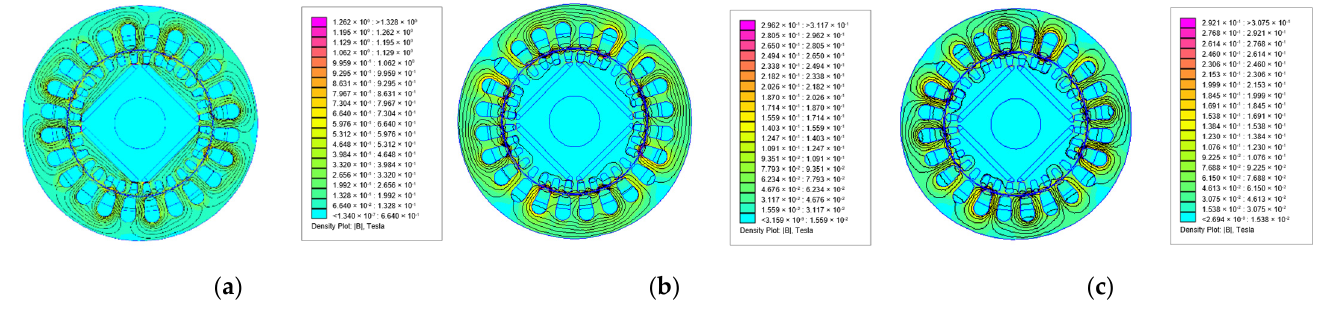
Figure 13. Density flux plot for ( a ) nominal conditions; ( b ) 2nd-order voltage harmonics and ( c ) 5th-order voltage harmonics.